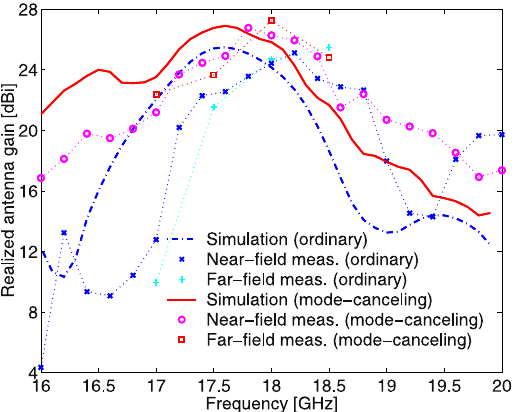
= = ) and mode-canceling main sub